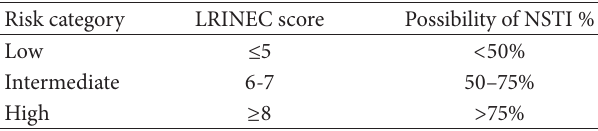
Table 2: Patient categories within LRINEC score according to the likelihood of necrotizing soft tissue infection (NSTI)